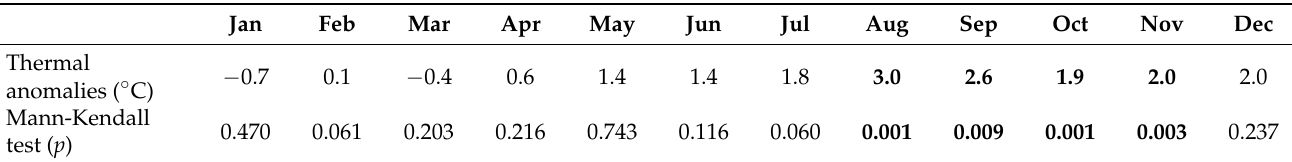
Table 1. The 2018 thermal anomalies (in bold) detected by applying the method proposed by Jim é nez- Muñoz et al. [47].